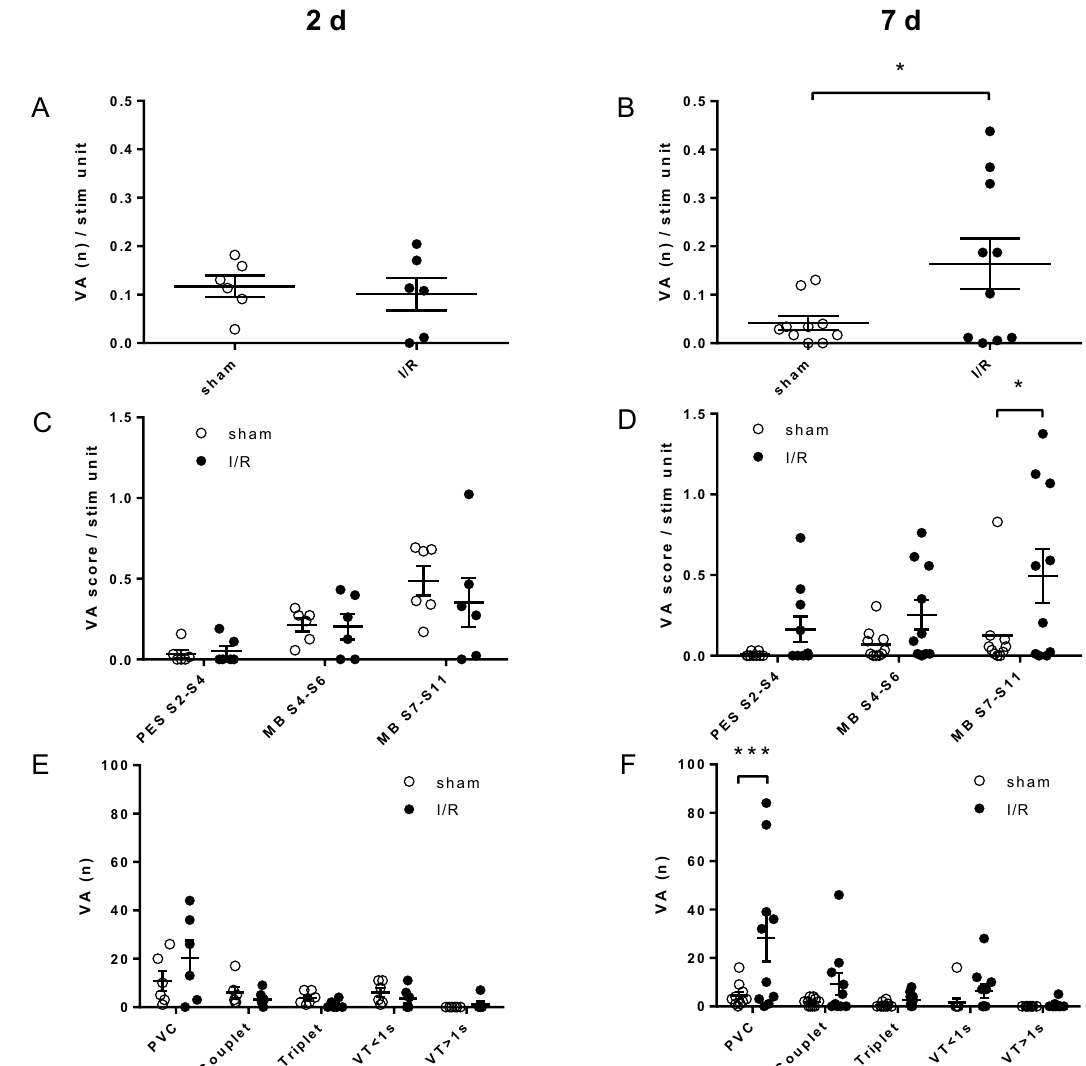
Figure 3. I/R raises the electrical ventricular vulnerability. ( A ) EPS reveals a similar burden of VA at 2 days after I/R compared to sham operated controls ( p = 0.731, n = 6, unpaired two-sided t -test). ( B ) The number of VA inductions increases significantly 7 days after I/R over sham controls ( p = 0.038, n = 10, unpaired two-sided t -test). ( C ) The severity of VA at 2 days is indifferent between groups independent of the used PES protocol (two-way ANOVA (Sidak); S2–S4, p = 0.998; S4–S6, p = 0.999; S7–S11, p = 0.596; n = 6). ( D ) Application of multiple extrastimuli is most efficient to elicit VA at 7 days post I/R over sham control (MB S7–S11, * p =